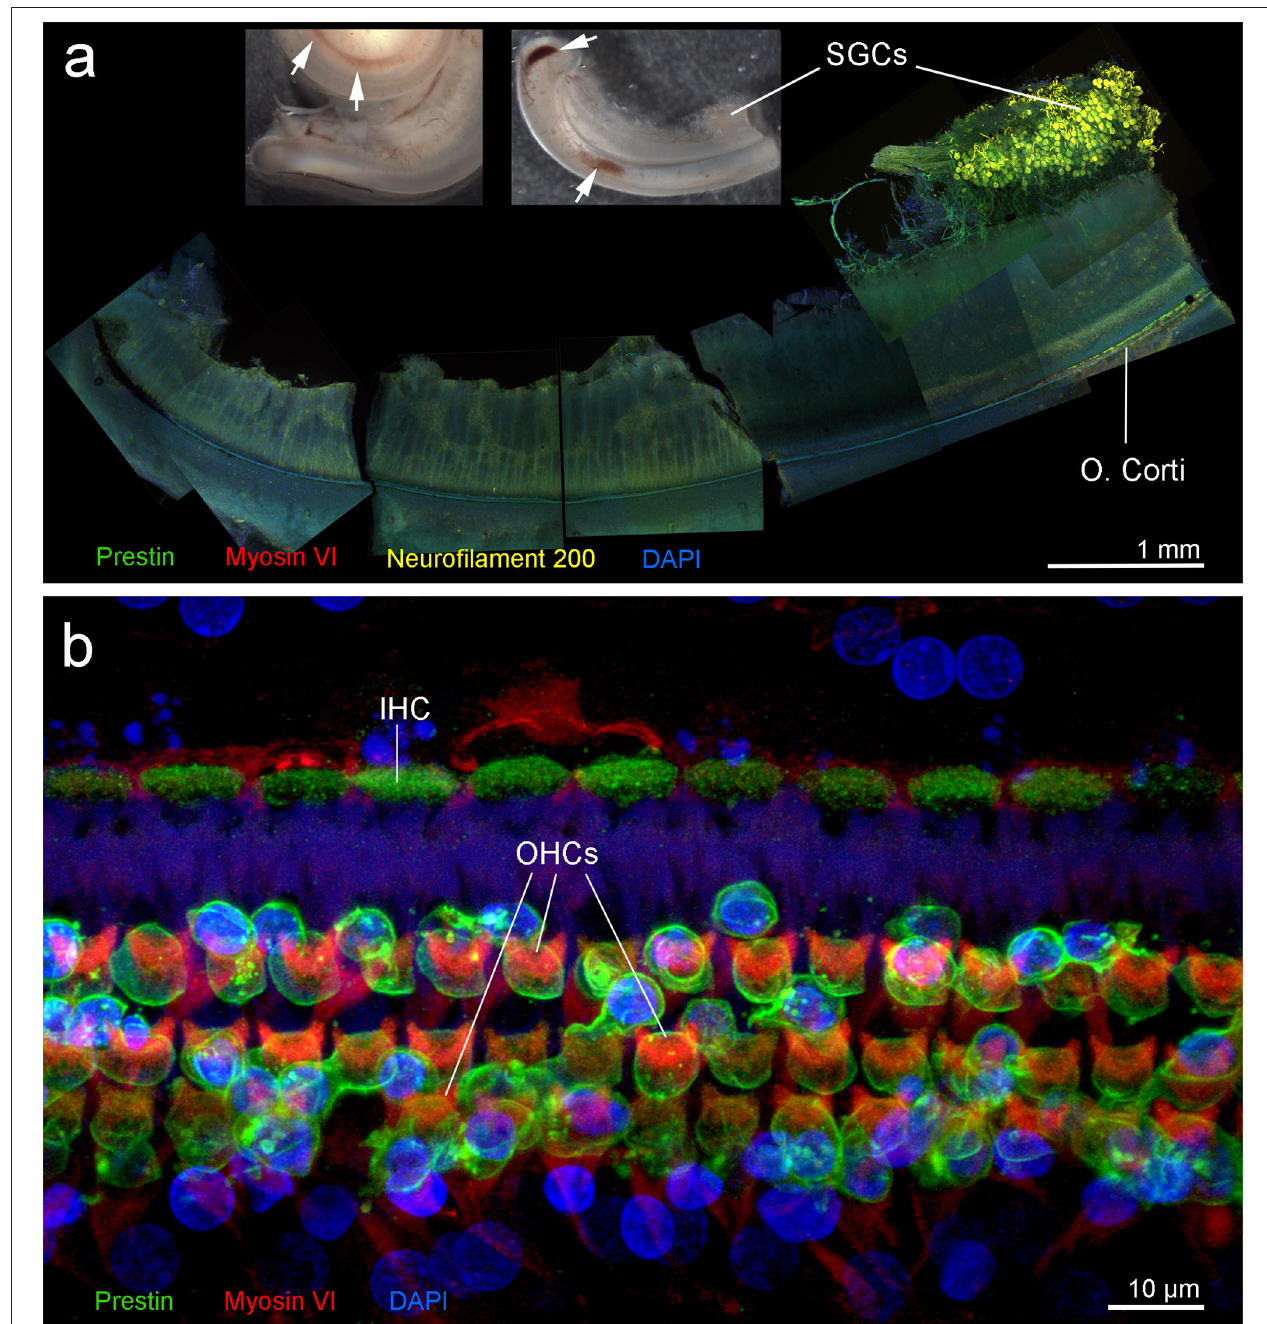
FIGURE 4 | Right cochlea from the beluga Qila. (a) Sub-gross focal hemorrhage (arrows) and immunofluorescence image of the hook or most basal part of the cochlea, where the highest frequencies are encoded. (b) Organ of Corti (O. Corti) of the lower apical turn, formed by three rows of outer hair cells (OHCs) and one row of inner hair cells (IHCs). Flat preparations of the cochlea were incubated with antibodies against prestin (green), myosin VI (red), neurofilament 200 kD (yellow) and DAPI (blue). SGCs, spiral ganglion cells.